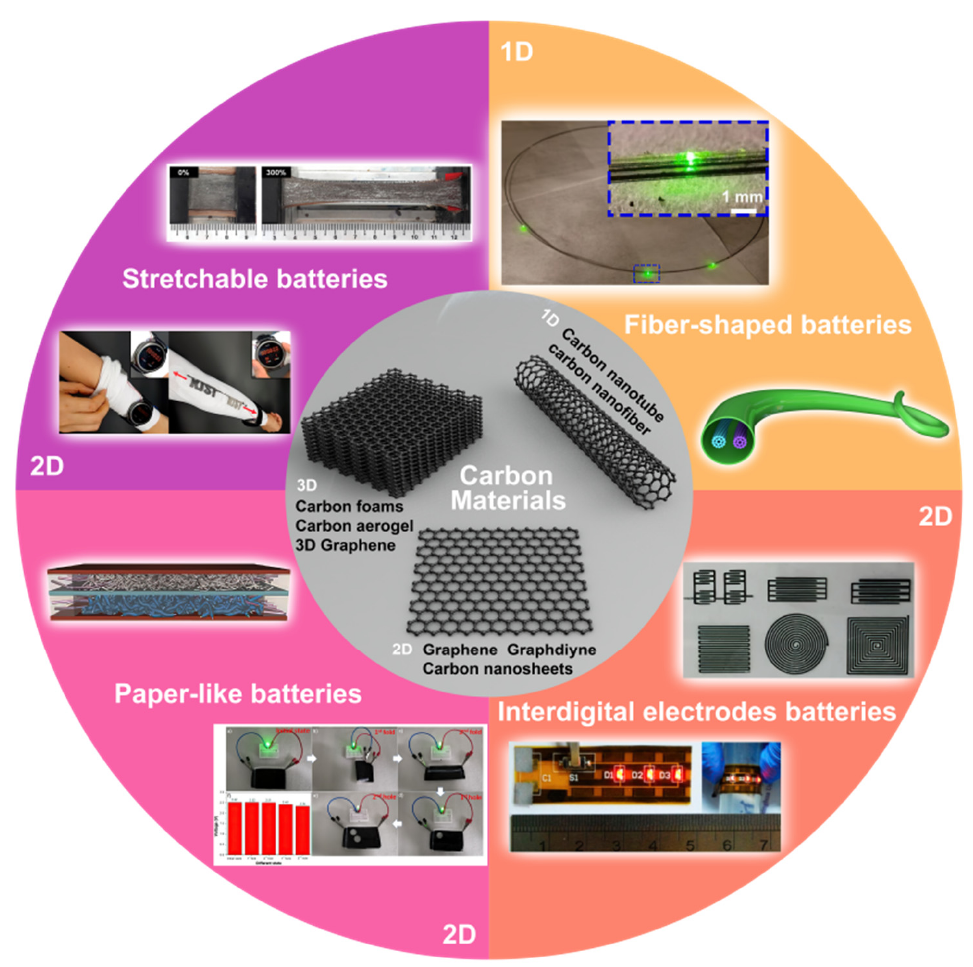
Figure 1. Schematic diagram of carbon materials and their application in FLIBs.